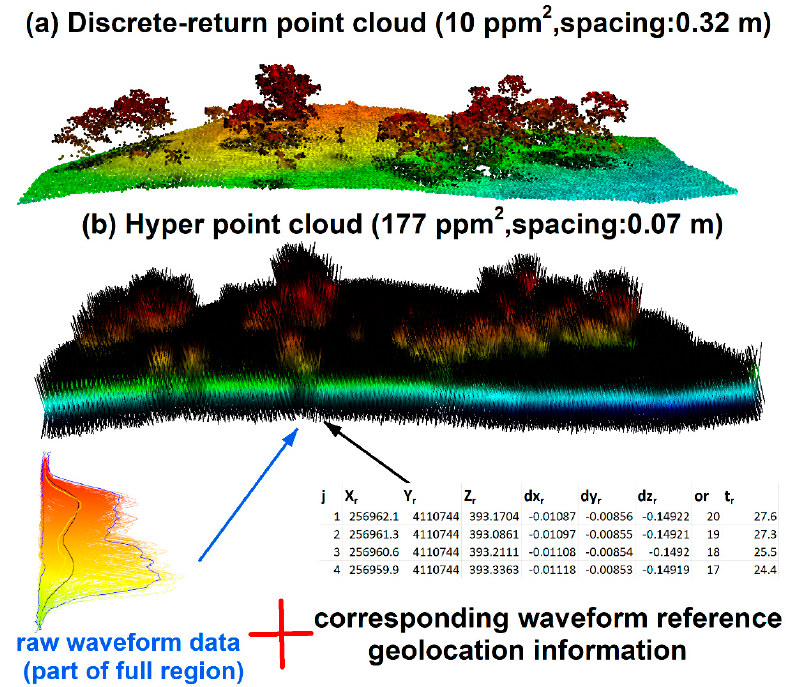
Figure 6. ( a ) Discrete-return point cloud. ( b ) Illustration of the Hyper Point Cloud (HPC) generation concept using raw waveform data (blue) and corresponding waveform reference geolocation information (black).